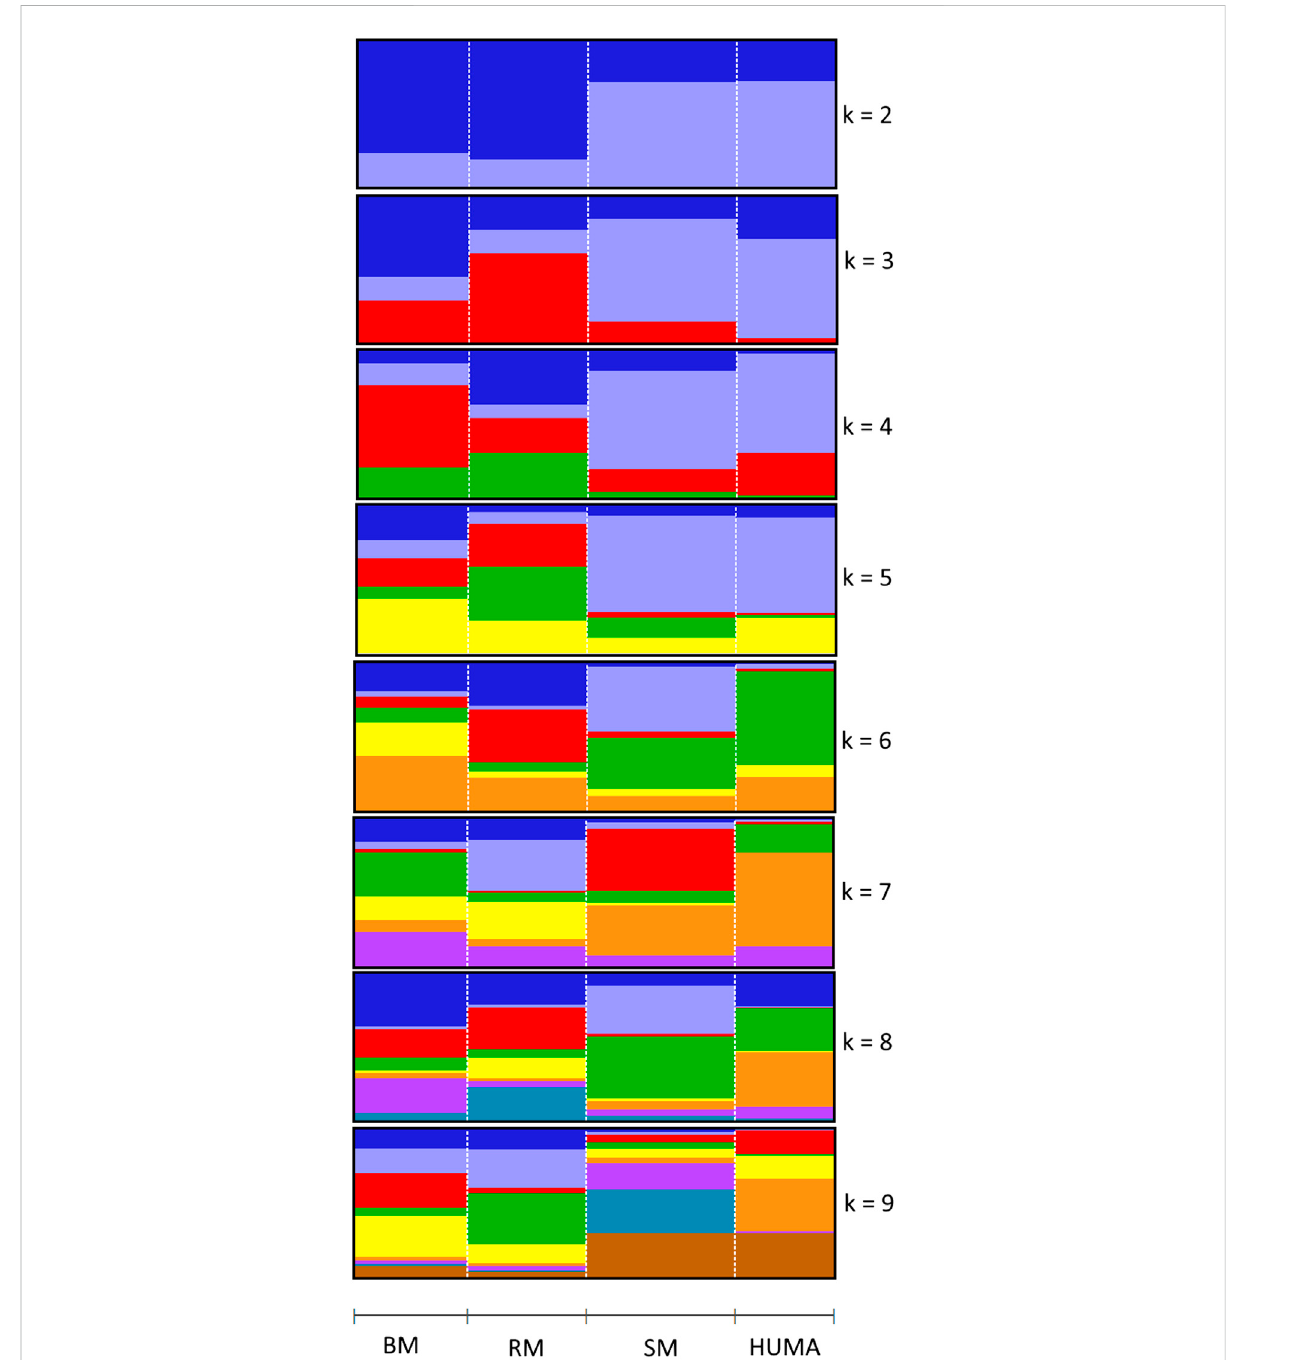
FIGURE 3 AdmixtureanalysisoffourMangalitsapigspopulations(BM,RM,SMandHUMA)withgraphsrepresentingclusterlevels2through9.Theoptimal cluster level was found at k =